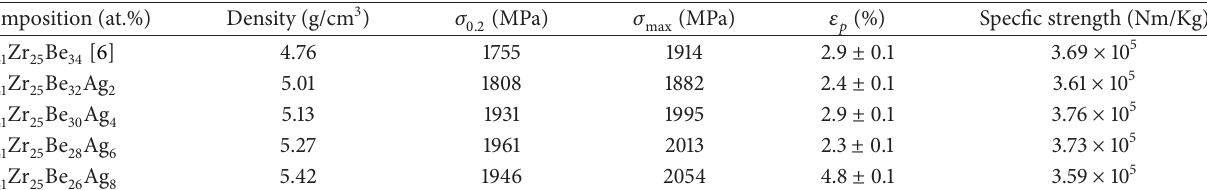
Zr Be 34−𝑥 Ag 𝑥 ( 𝑥 = 2 , 4, 6, 8 at.%) BMGs. 41 25